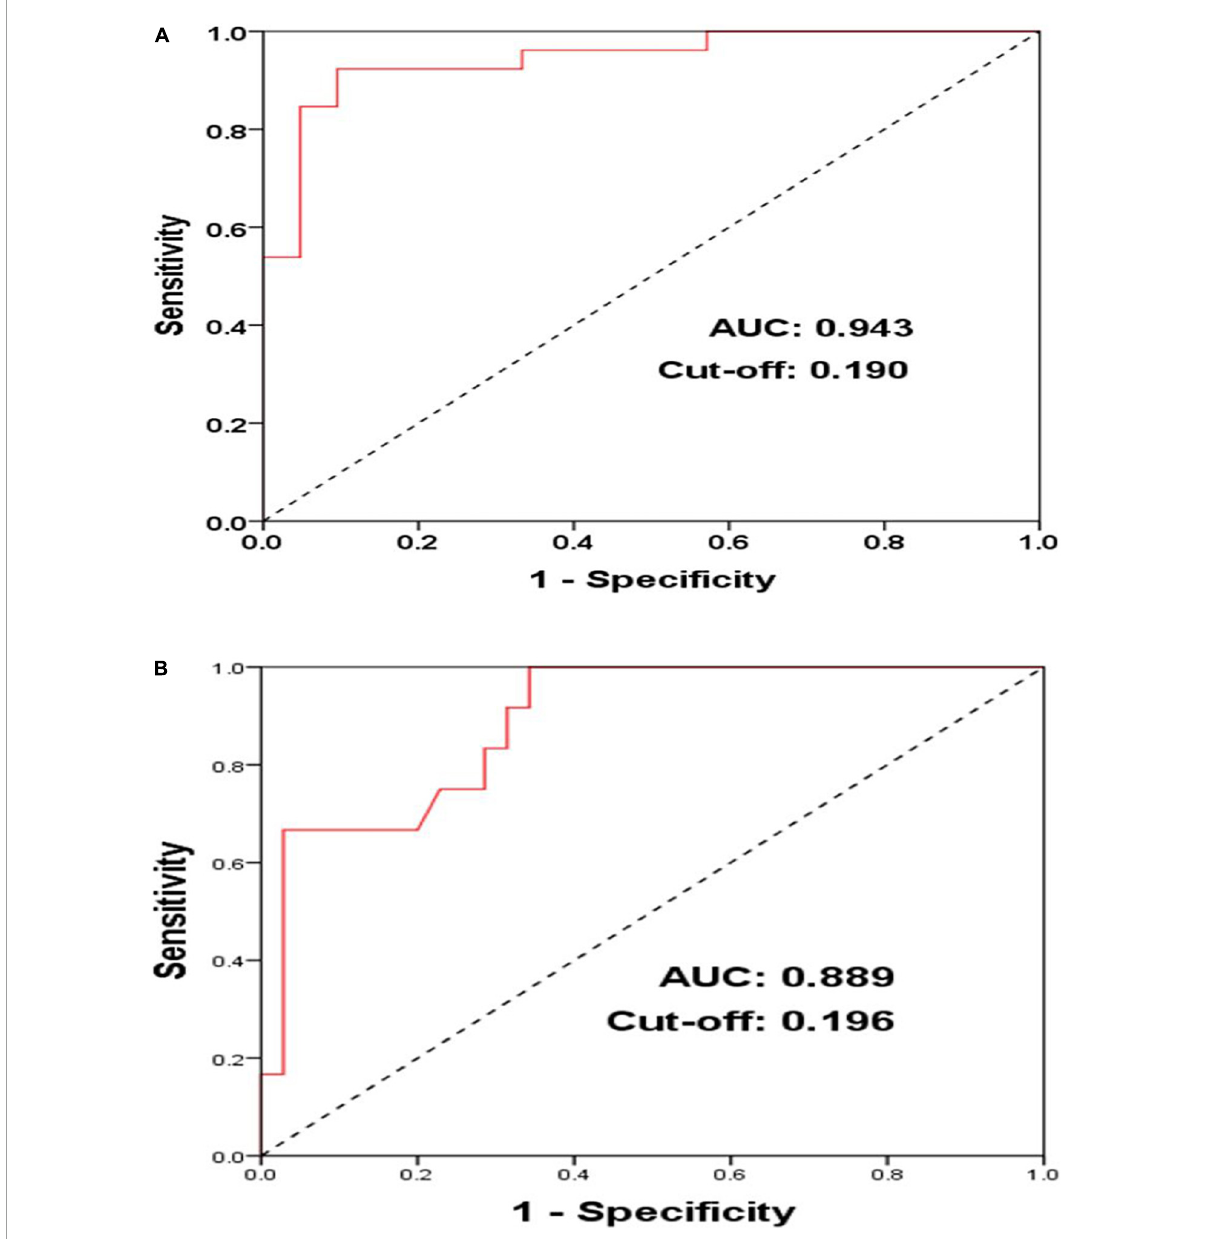
FIGURE3 ROC (receiver operator curves) of acute AF induction (A) and middle-term follow-up of atrial arrhythmia recurrences (B) according to LVA in PersAF patients with blocked CSD-LA muscular connection ( n =